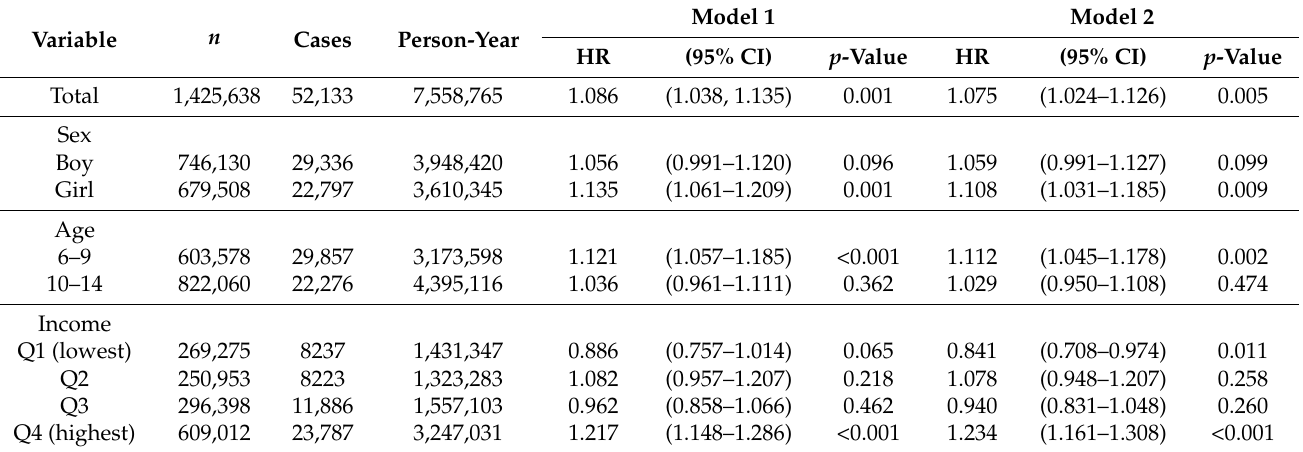
Table 3. HRs for asthma incidence per 10 µ g/m 3 in the 48-month moving average of PM 2.5 level